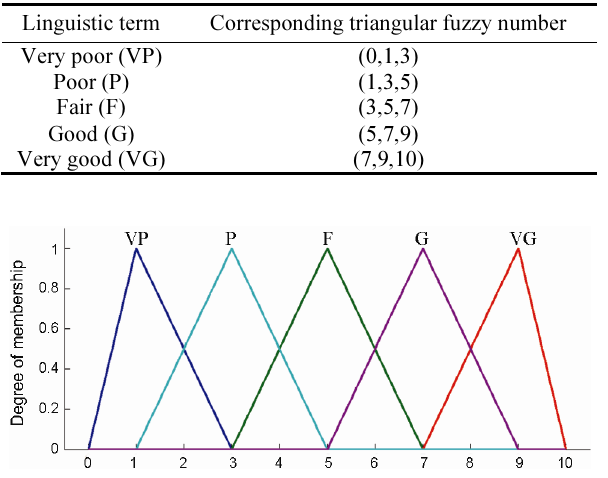
Fig. 2. Membership functions of linguistic values for preference